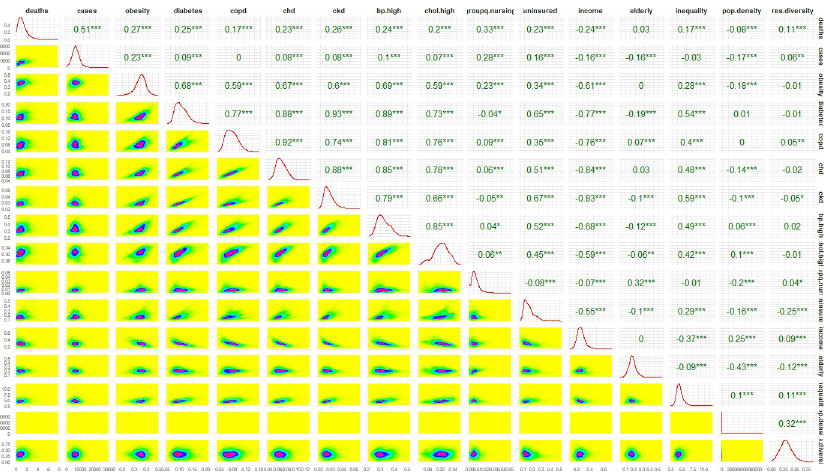
Fig 4. Pairwise surface plots (below diagonal), Spearman correlation (above diagonal), and density (diagonal) of outcome and measures used in the study. � indicates level of statistical significance of the correlation: p < 0.001 ( ��� ); 0.001 � p < 0.01 ( �� ); 0.01 � p < 0.05 ( �